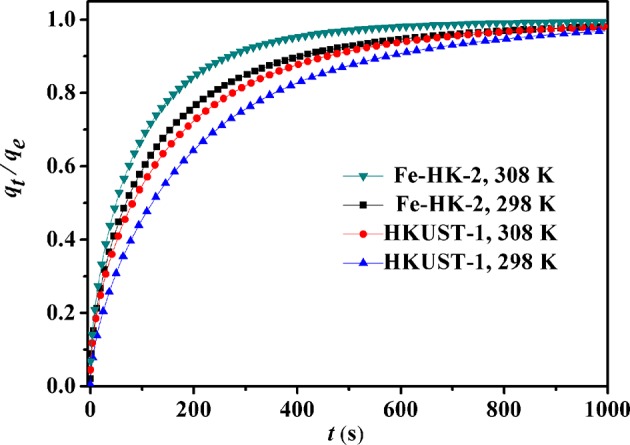
Fractional uptakes of benzene on HKUST-1 and Fe-HK-2 at 0.2 kPa.